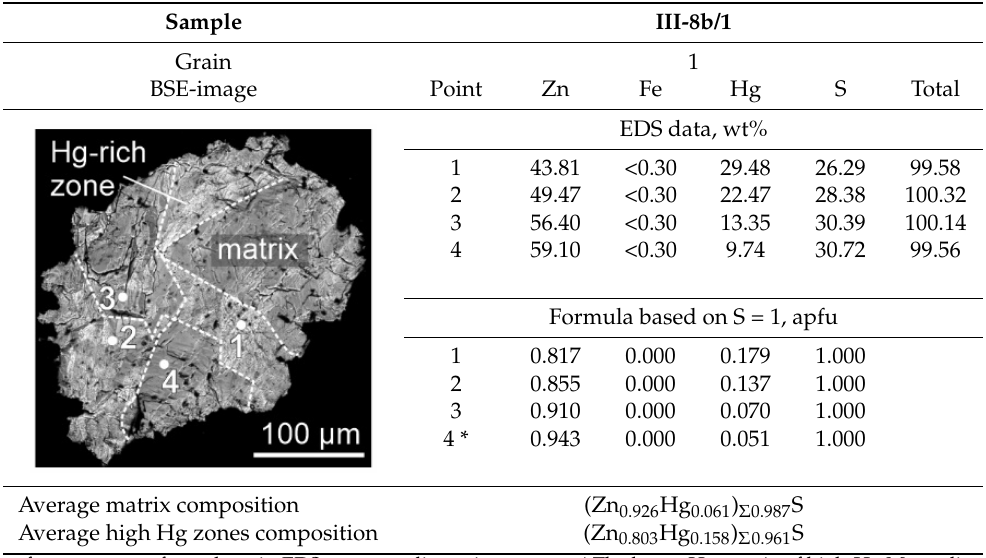
Table 1. Back-scattered electron (BSE) image and representative compositions of reference